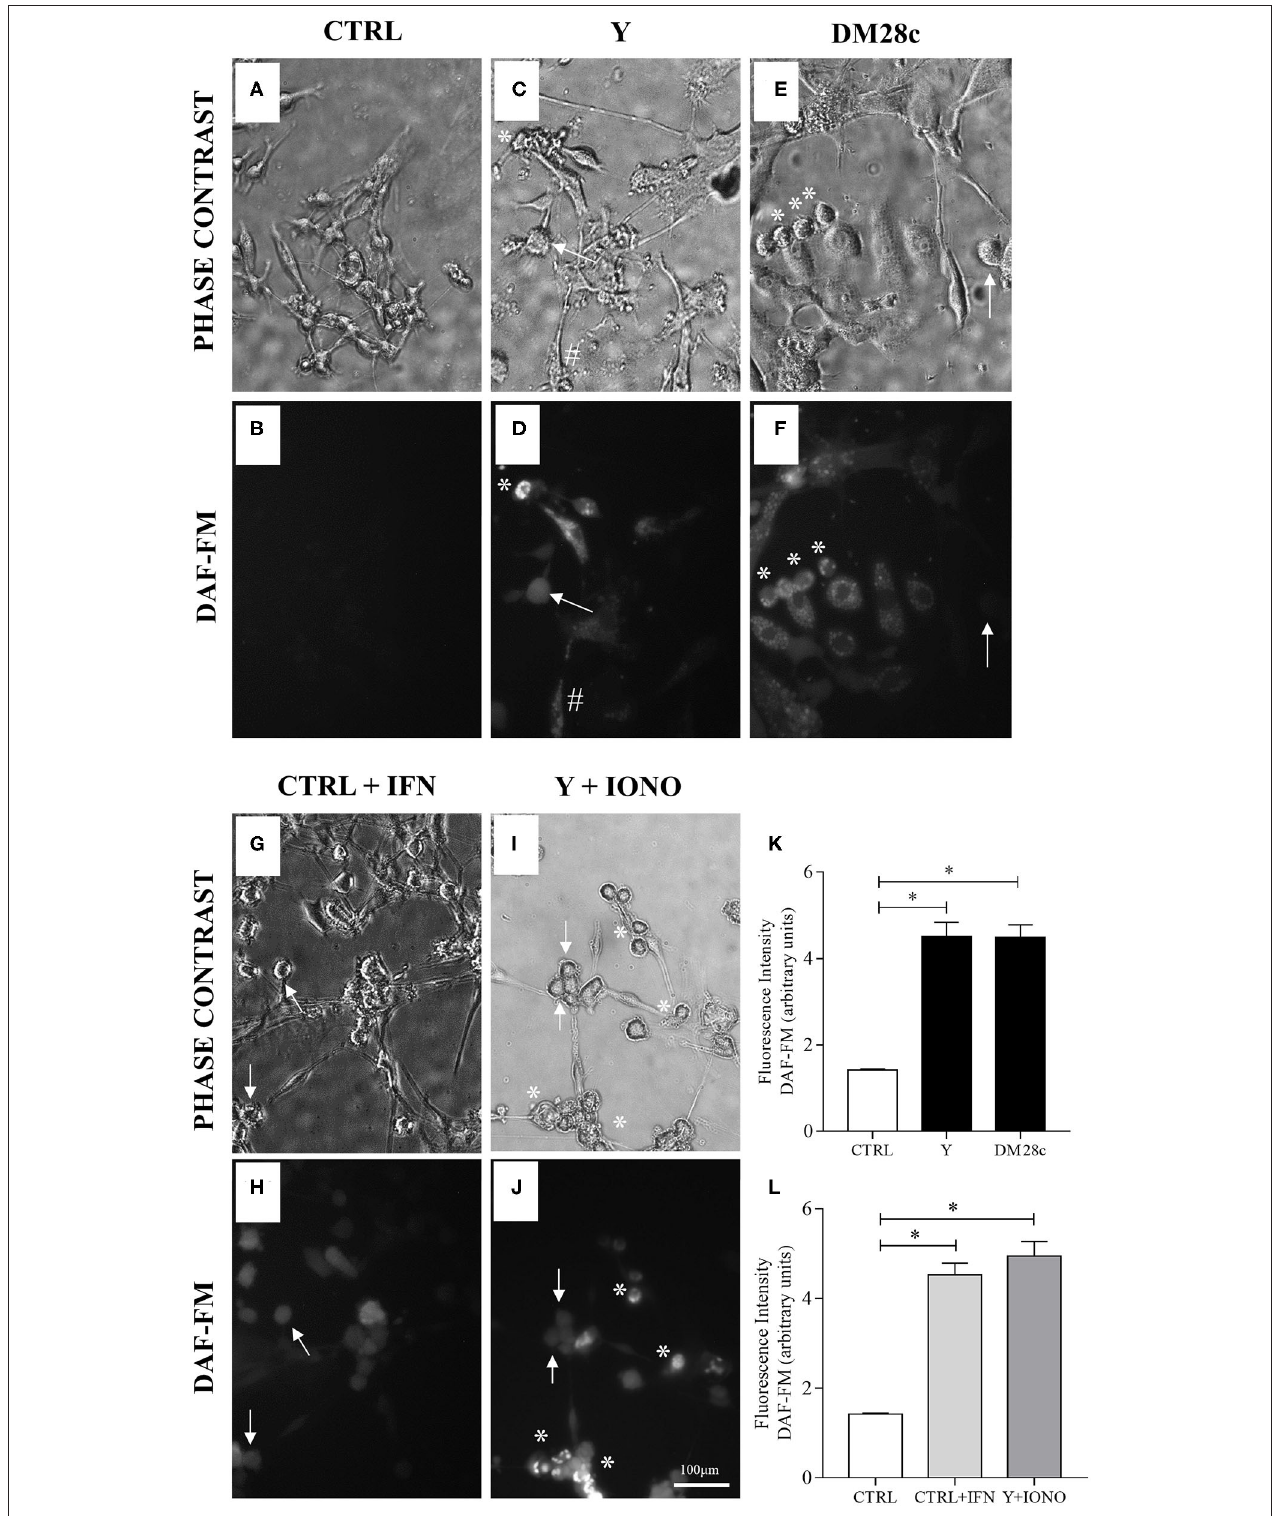
FIGURE 5 | Neuronal nitric oxide production in myenteric neuronal cultures indicated by DAF-FM probe oxidation. Neurons removed from the myenteric plexus were dissociated, plated, and infected or not with T. cruzi strains Y and Dm28c trypomastigotes for 72h. Then, the coverslips were washed and exposed to